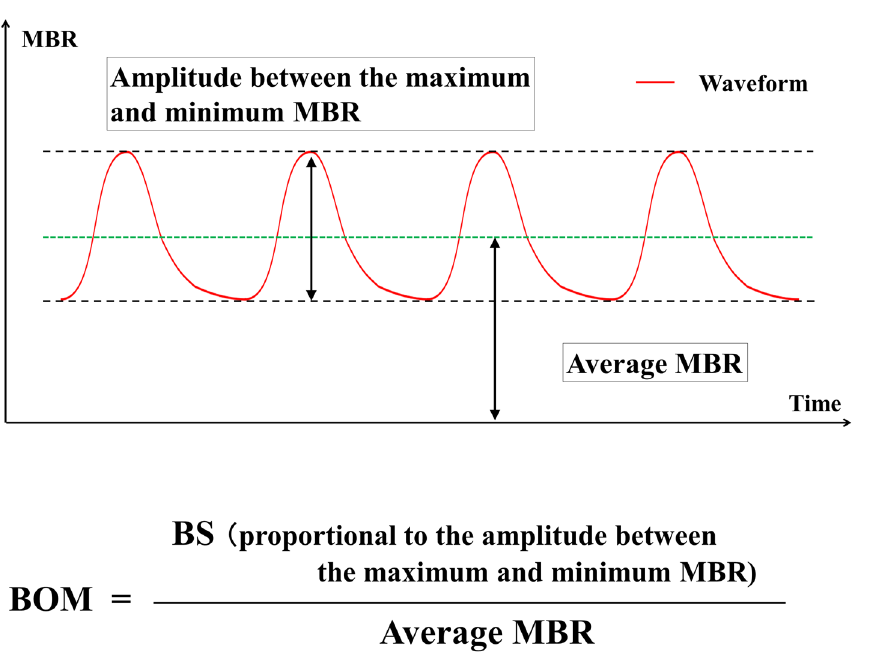
Figure 2. Schematic diagram of beat strength over mean blur rate (BOM). Beat strength (BS) is proportional to the amplitude between the maximum and minimum blood flow. BOM is BS divided by average